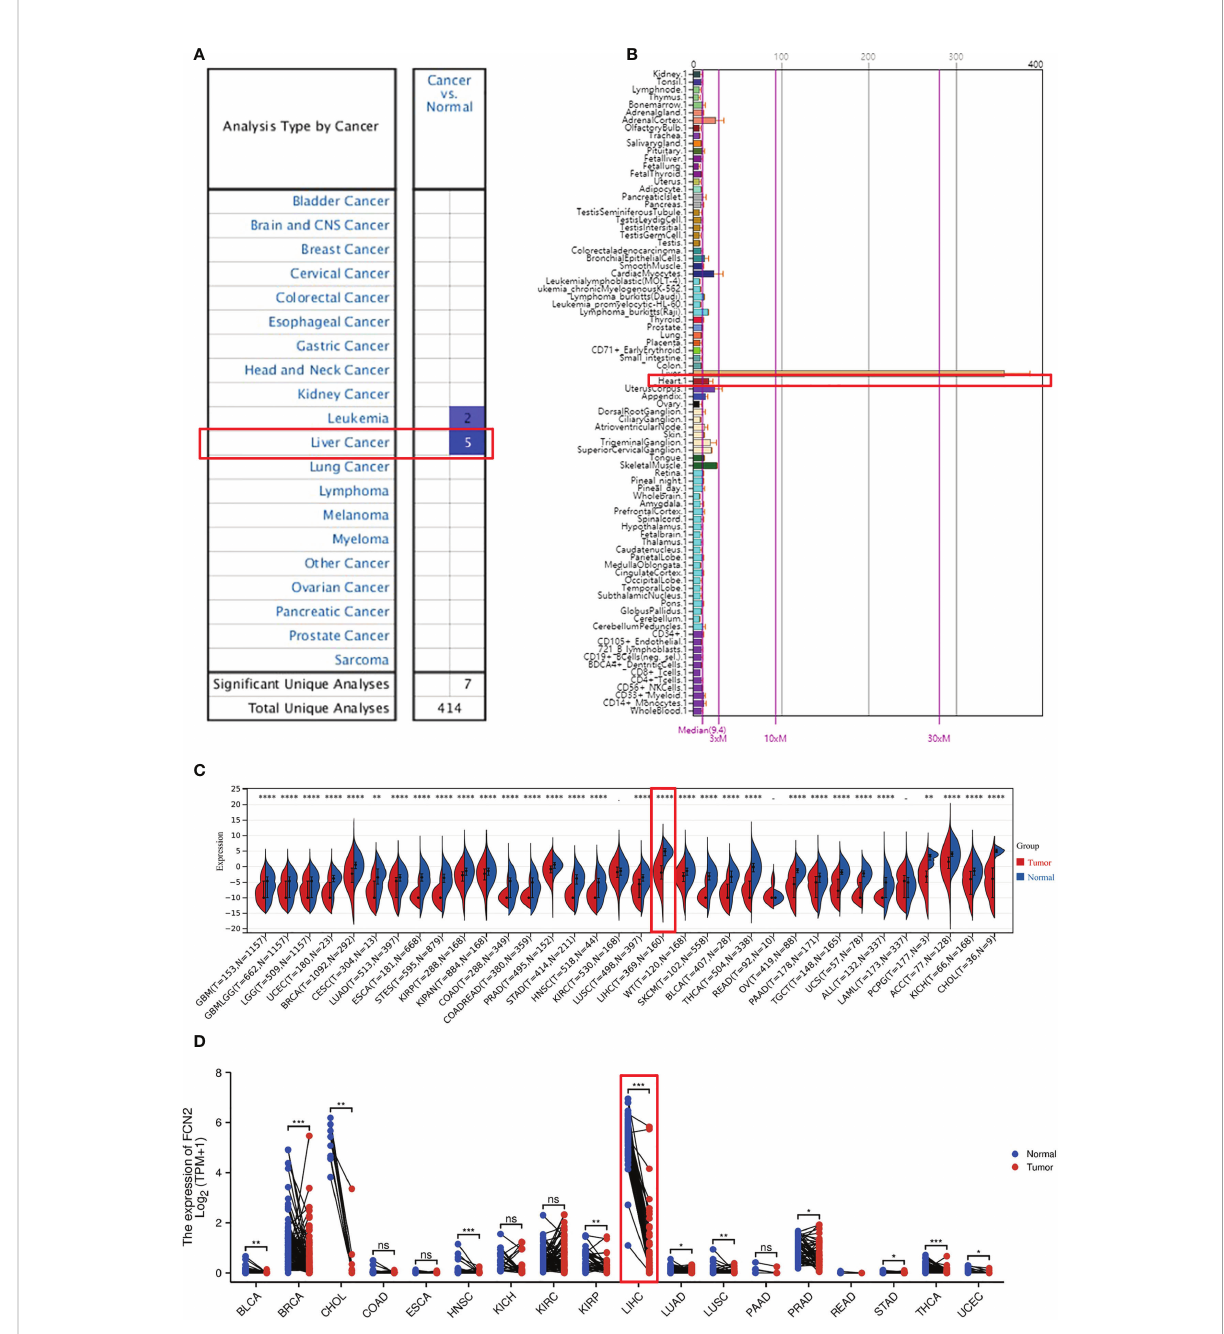
FIGURE 4 Pan-tissue expression of FCN2 . (A) Pan-cancer expression of FCN2 in the Oncomine database. (B) Expressionof FCN2 in normal tissues in the BioGPS database. (C) Pan-cancer expression of FCN2 in the UCSC (University of California, Santa Cruz) database. (D) Log2 transformation ofthe pan-cancer expressionvalue of FCN2 in the UCSCdatabase. * p < 0.05, ** p < 0.01, *** p < 0.001, **** p < 0.0001,ns: notstatistically signi fi